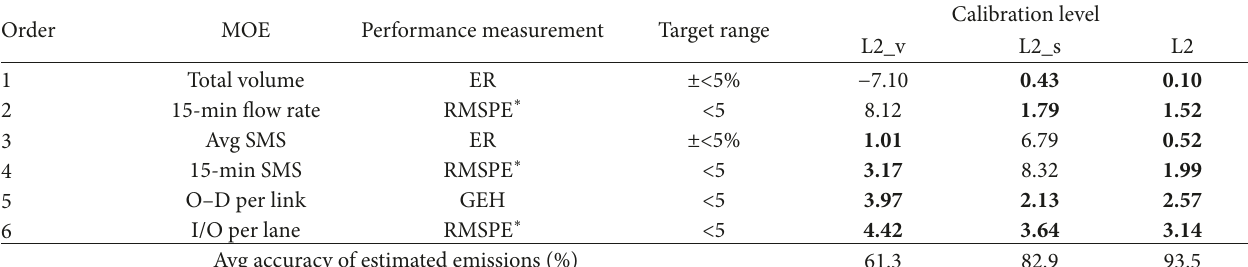
Table 5: Effect of calibration sequence on estimated emissions accuracy for calibration level L2.